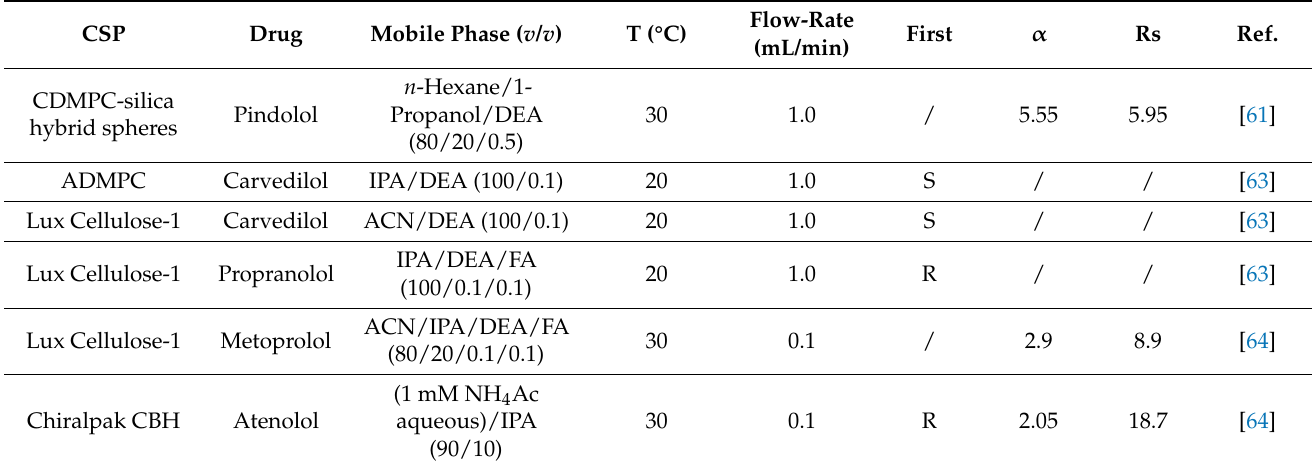
Table 4. Typical results for the enantioseparation of the β -blockers with polysaccharide based